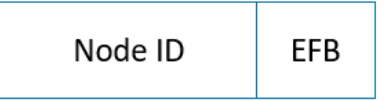
Figure 8. Message broadcasted by the buyer nodes stating a need for energy.